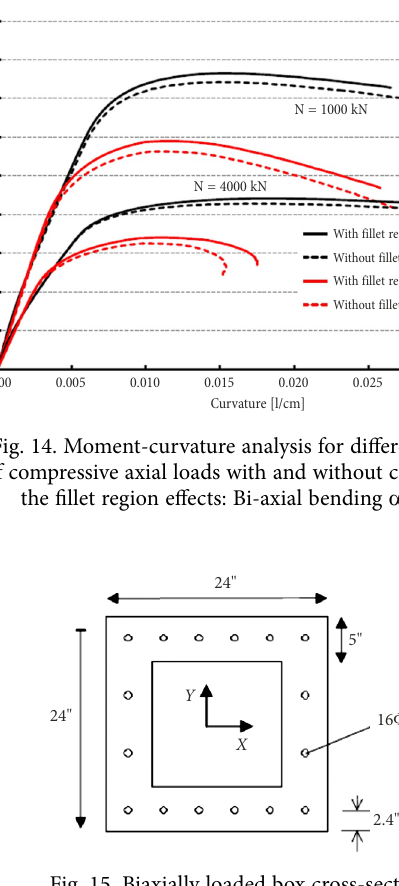
Fig. 15. Biaxially loaded box